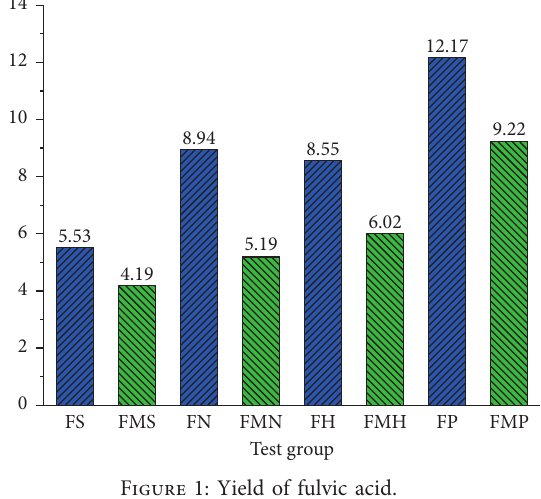
Figure 1: Yield of fulvic acid.